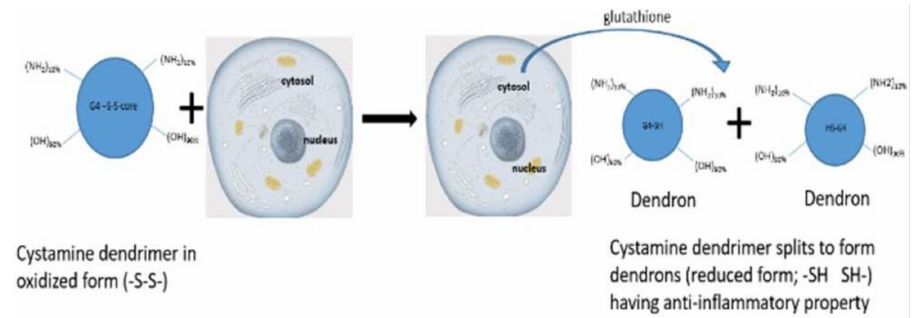
Figure 2. Dendrimer splitting. Upon entering the cell through non-mediated endocytosis, the dendrimer’s core gets reduced from -S-S- to -SH, splitting the dendrimer into two